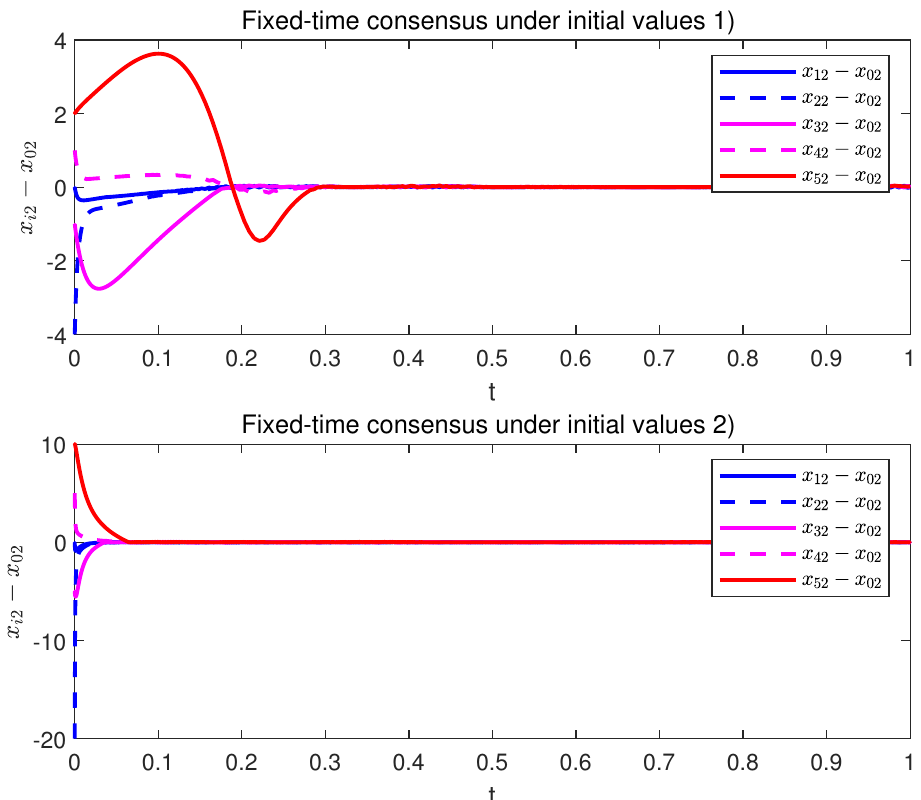
Figure 4. The trajectories of x i 2 for leader-following example under initial values (1) and